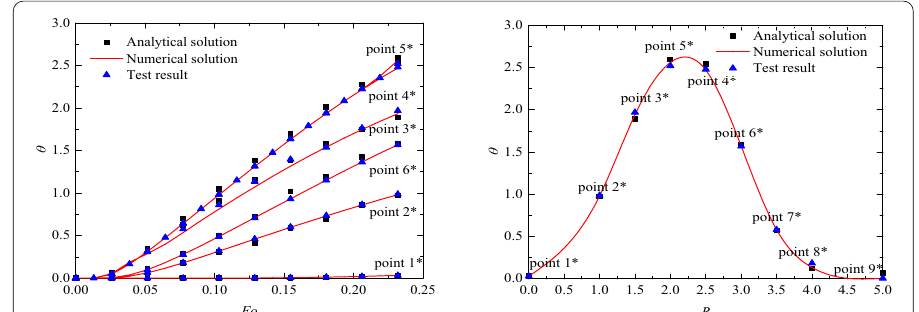
Fig. 6 Comparison of multi-tube (four-tube) analytical solution and numerical solution with experimental result ( y 0 m, z 0.5 m): a temperature response θ over Fo (the observation points 1* ~ 6*); b temperature = = response θ over dimensionless distance L ( Fo =